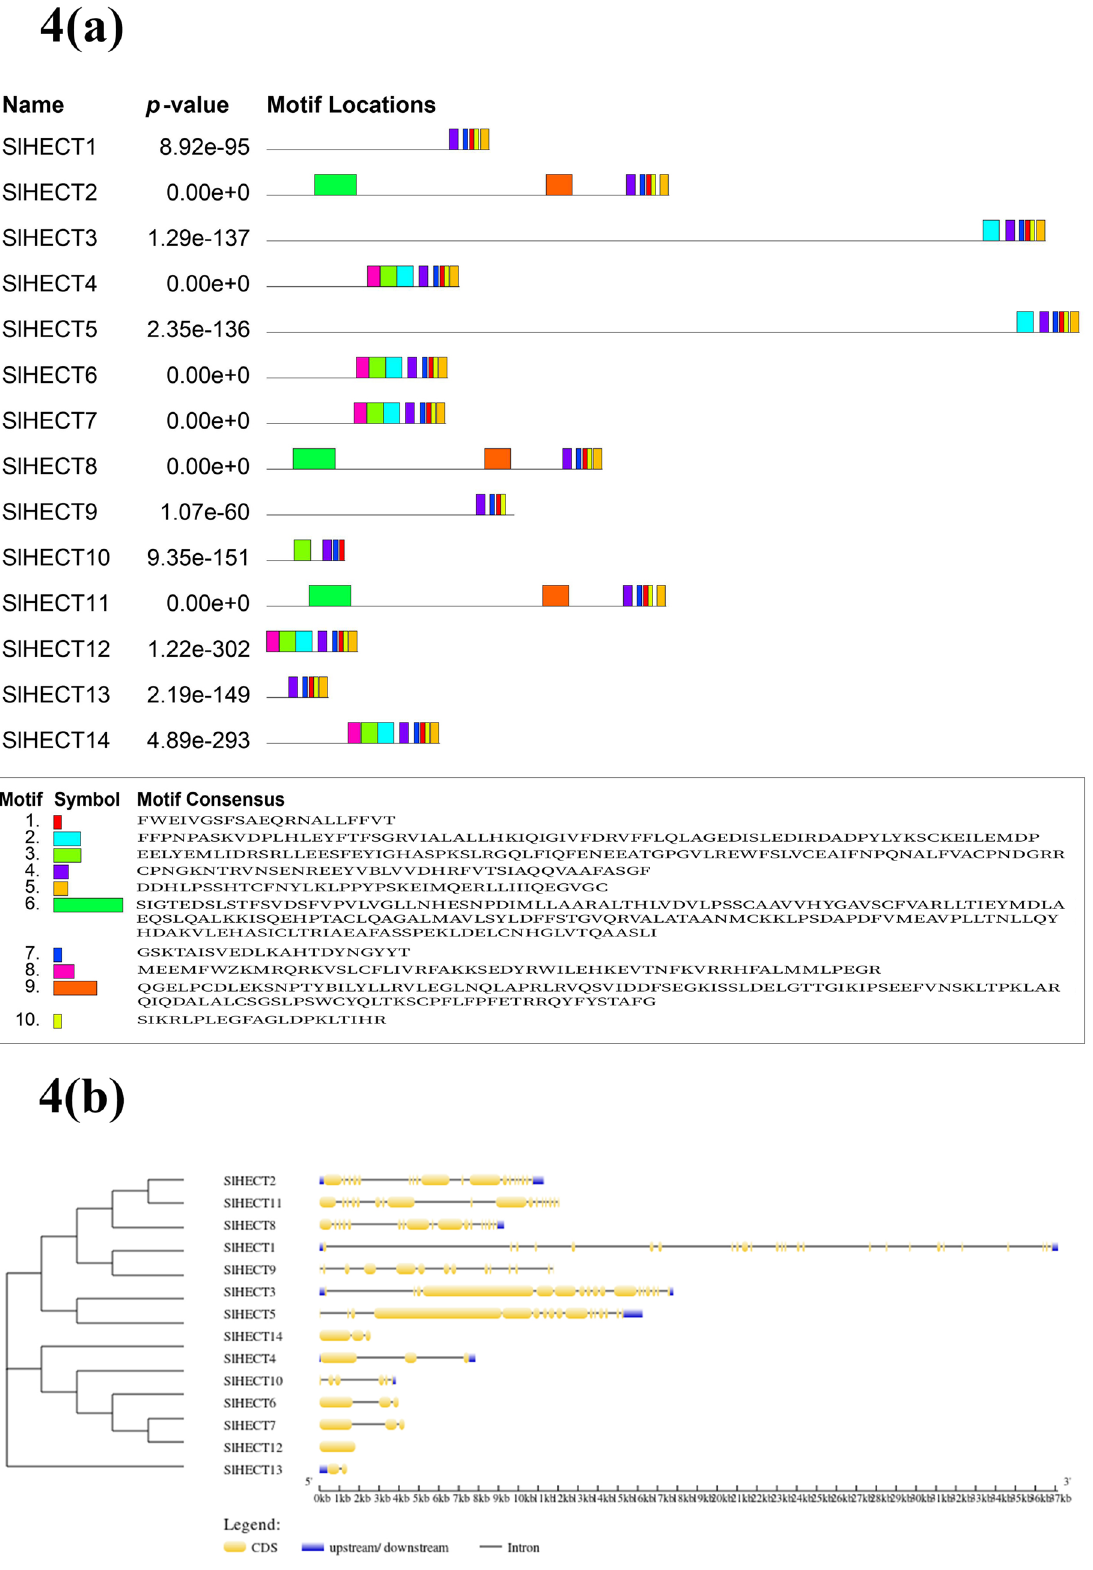
Figure 4. ( a ) Schematic representation of ten motifs discovered in tomato HECT E3 ubiquitin ligase gene family through MEME tool denoted by different colors ( b ) The exon/intron distribution of the fourteen tomato HECT E3 ubiquitin ligase gene family was determined by the GSDS tool, by comparing the coding sequences (CDS) with the relative genomic sequences. The yellow box represents the CDS; the solid black line depicts the intron region and the blue box shows upstream/downstream